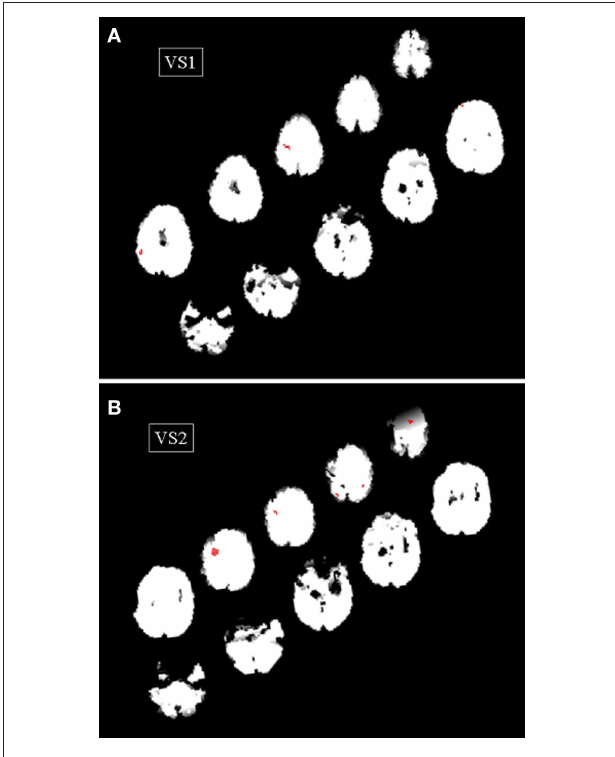
Figure A2 | results of the right vs. left movement contrast (red) superimposed on the original SPM masks for VS1 (A) and VS2 (B) .